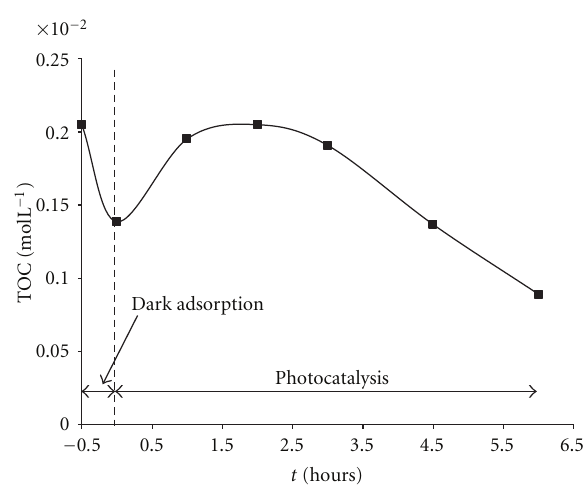
Figure 2: Temporal course for shower water photocatalysis at optimum conditions (TOC initial concentration = 24 . 62 ± 0 . 44mgL − 1 , average reaction temperature = 27 ◦ C, initial slurry pH = 3 . 00,0 . 07 gL − 1 catalyst loading, 1.8 Lmin − 1 air flow rate and 4.4Lmin − 1 slurry flow